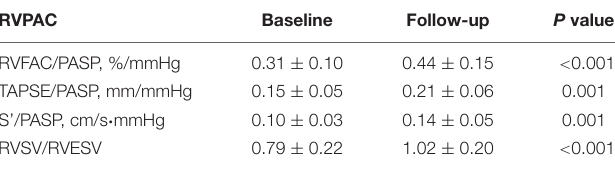
TABLE 4 | Right ventricular pulmonary arterial coupling at baseline and